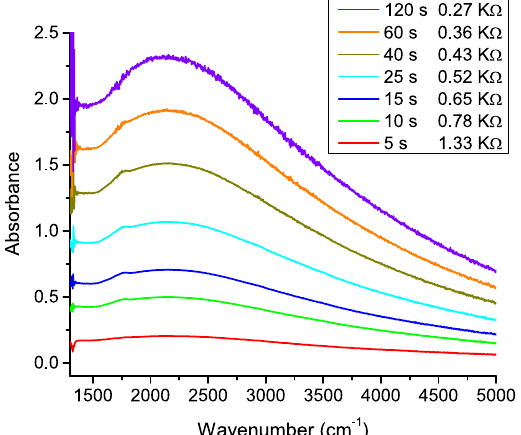
Figure 3. IR absorption and two-point resistance values as a function of light exposure duration (405 nm wavelength). The crystal had a resistance of 2.56 MΩ prior to light exposure. An IR spectrum from the unexposed crystal was used as a reference for the absorbance plots. Note: 1000 cm − 1 = 0.124 eV.